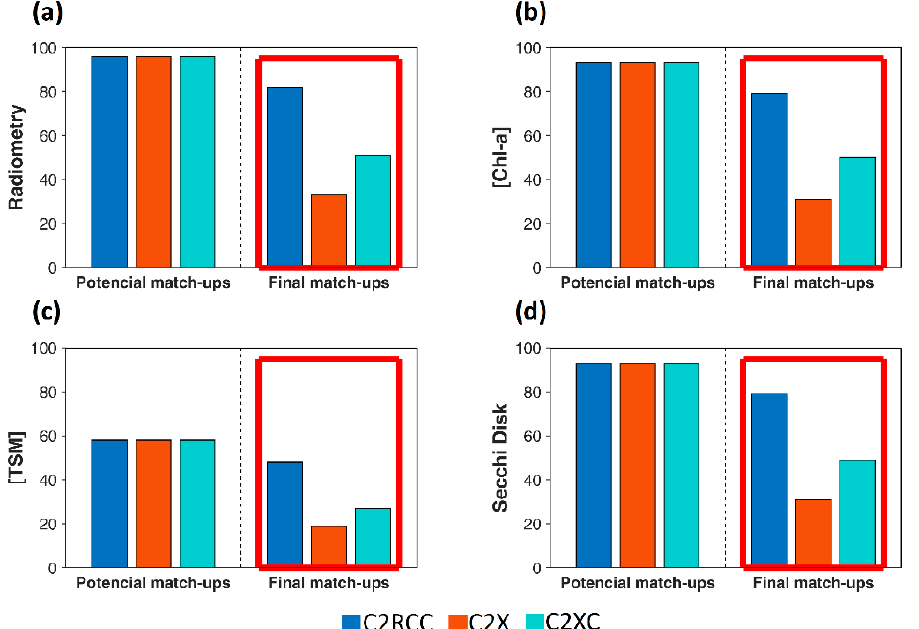
Figure 4. Match-up exercise by sub-dataset and C2-Nets: ( a ) Radiometry, ( b ) [Chl- a ], ( c ) [TSM], ( d ) Secchi disk. Final match-ups for each C2-Net are highlighted with a red square. ( d ) Secchi disk. Final match-ups for each C2-Net are highlighted with a red